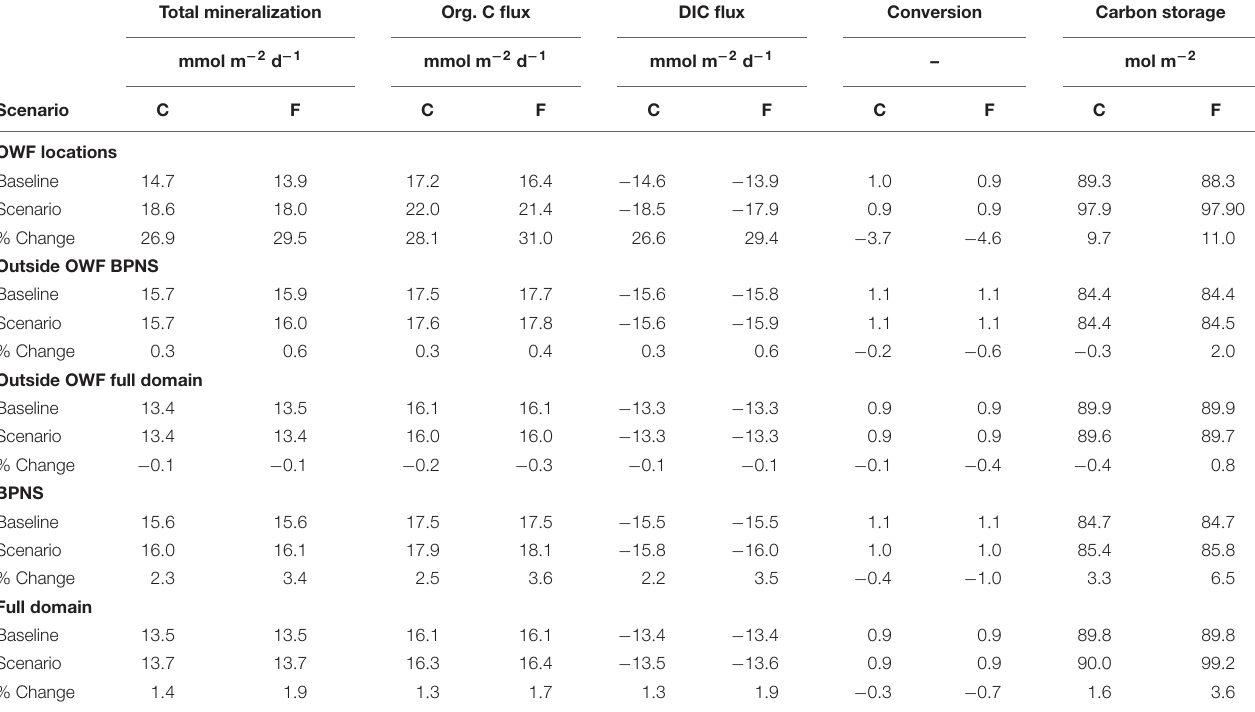
TABLE 4 | Averaged values and relative changes between tested scenarios and the baseline of carbon mineralization processes for the current (C) and future (F) scenarios, subdivided in values over locations with OWFs, the BPNS excluding OWFs (far-field BPNS), the domain excluding OWFs (Far-field domain), the BPNS, and the full